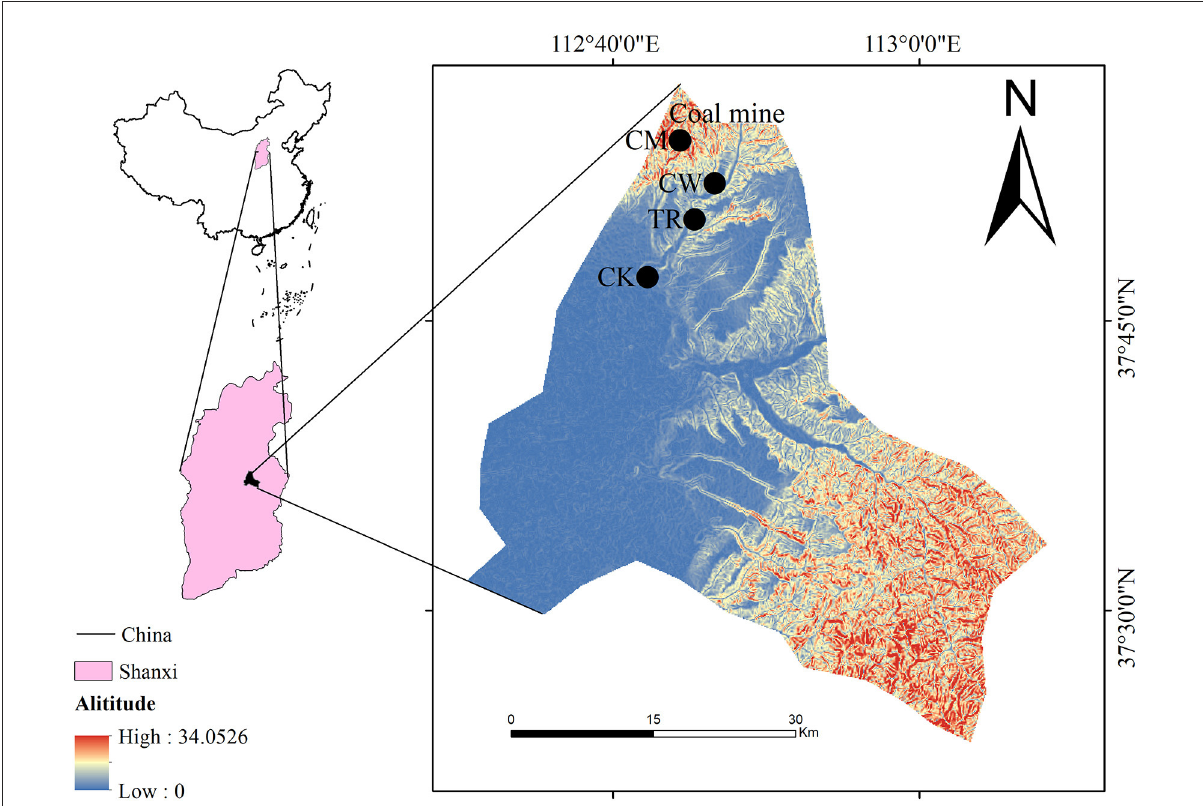
FIGURE1 Soil and maize sampling sites in the Jinzhong City, Shanxi Province, Northern China. The Beishan coal mining plant, CM; the coal washing plant near the Hanshan coal mining area, CW; the coal transportation road, TR; the control area,